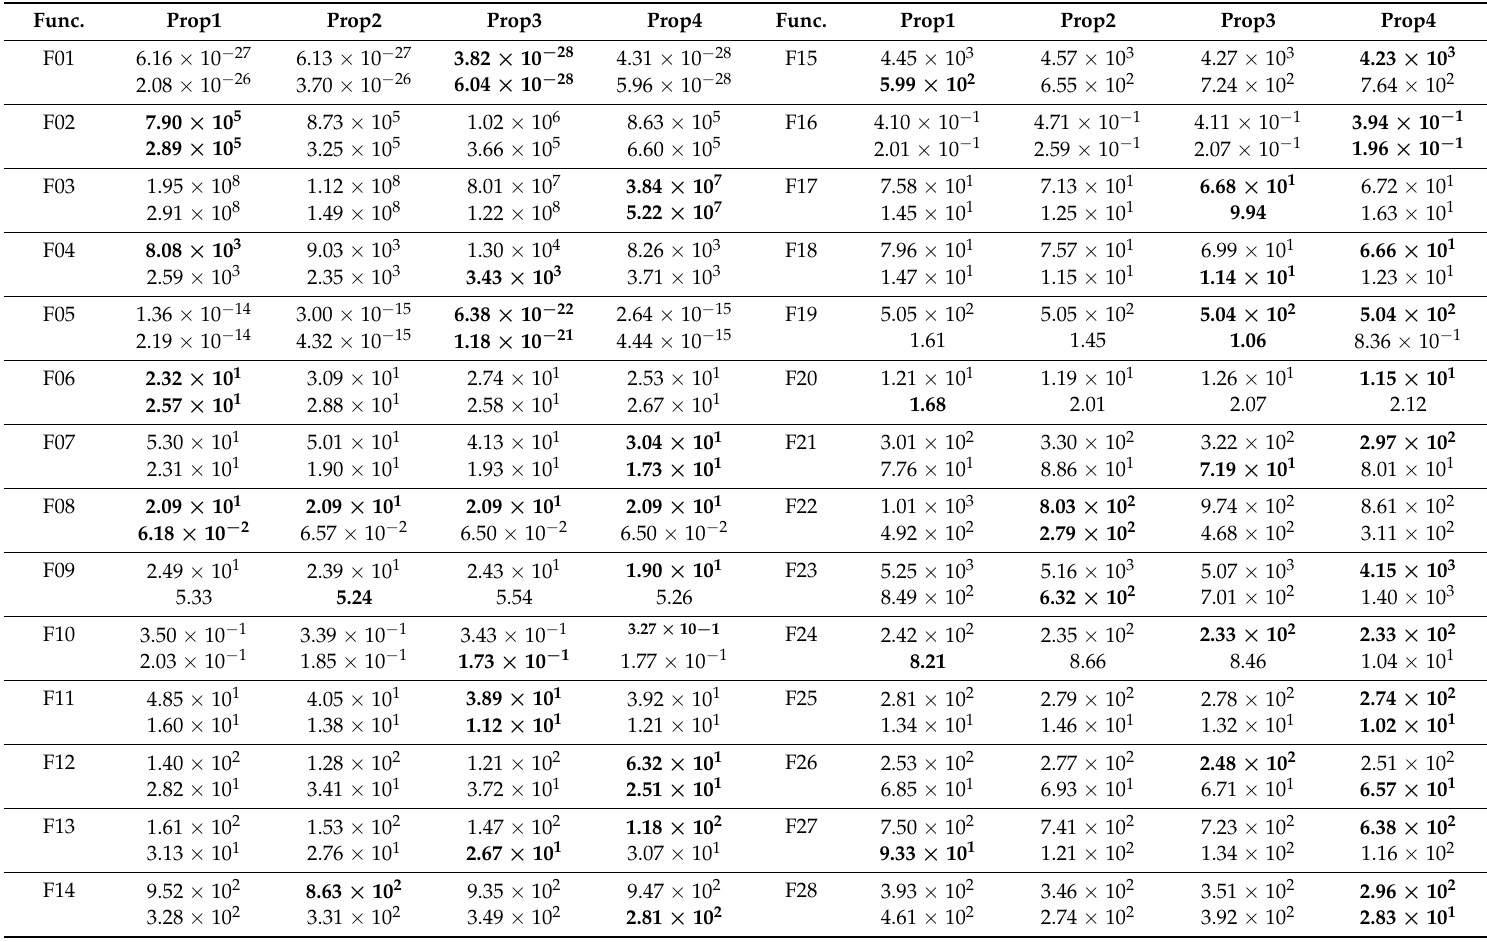
Table 6. Compared results of different interval